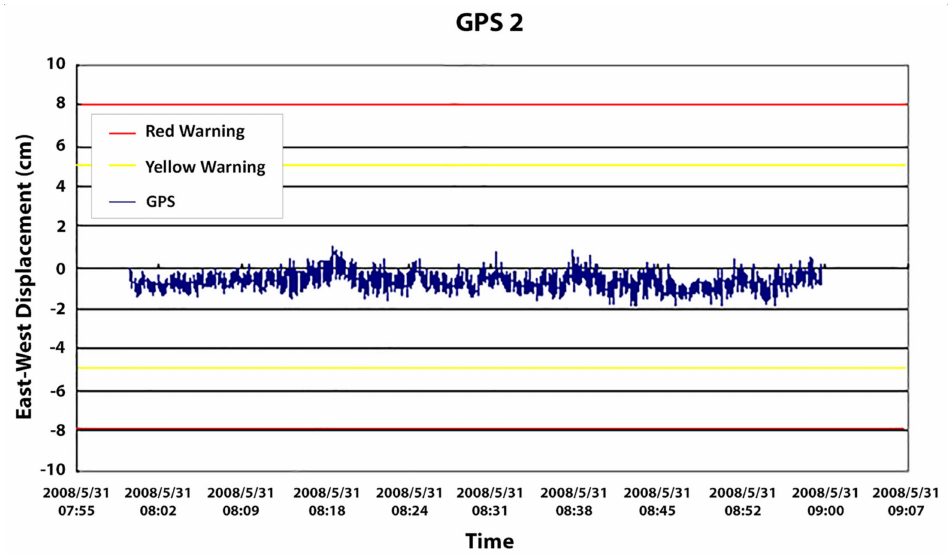
Figure 15. GPS-2 horizontal displacement quantities.